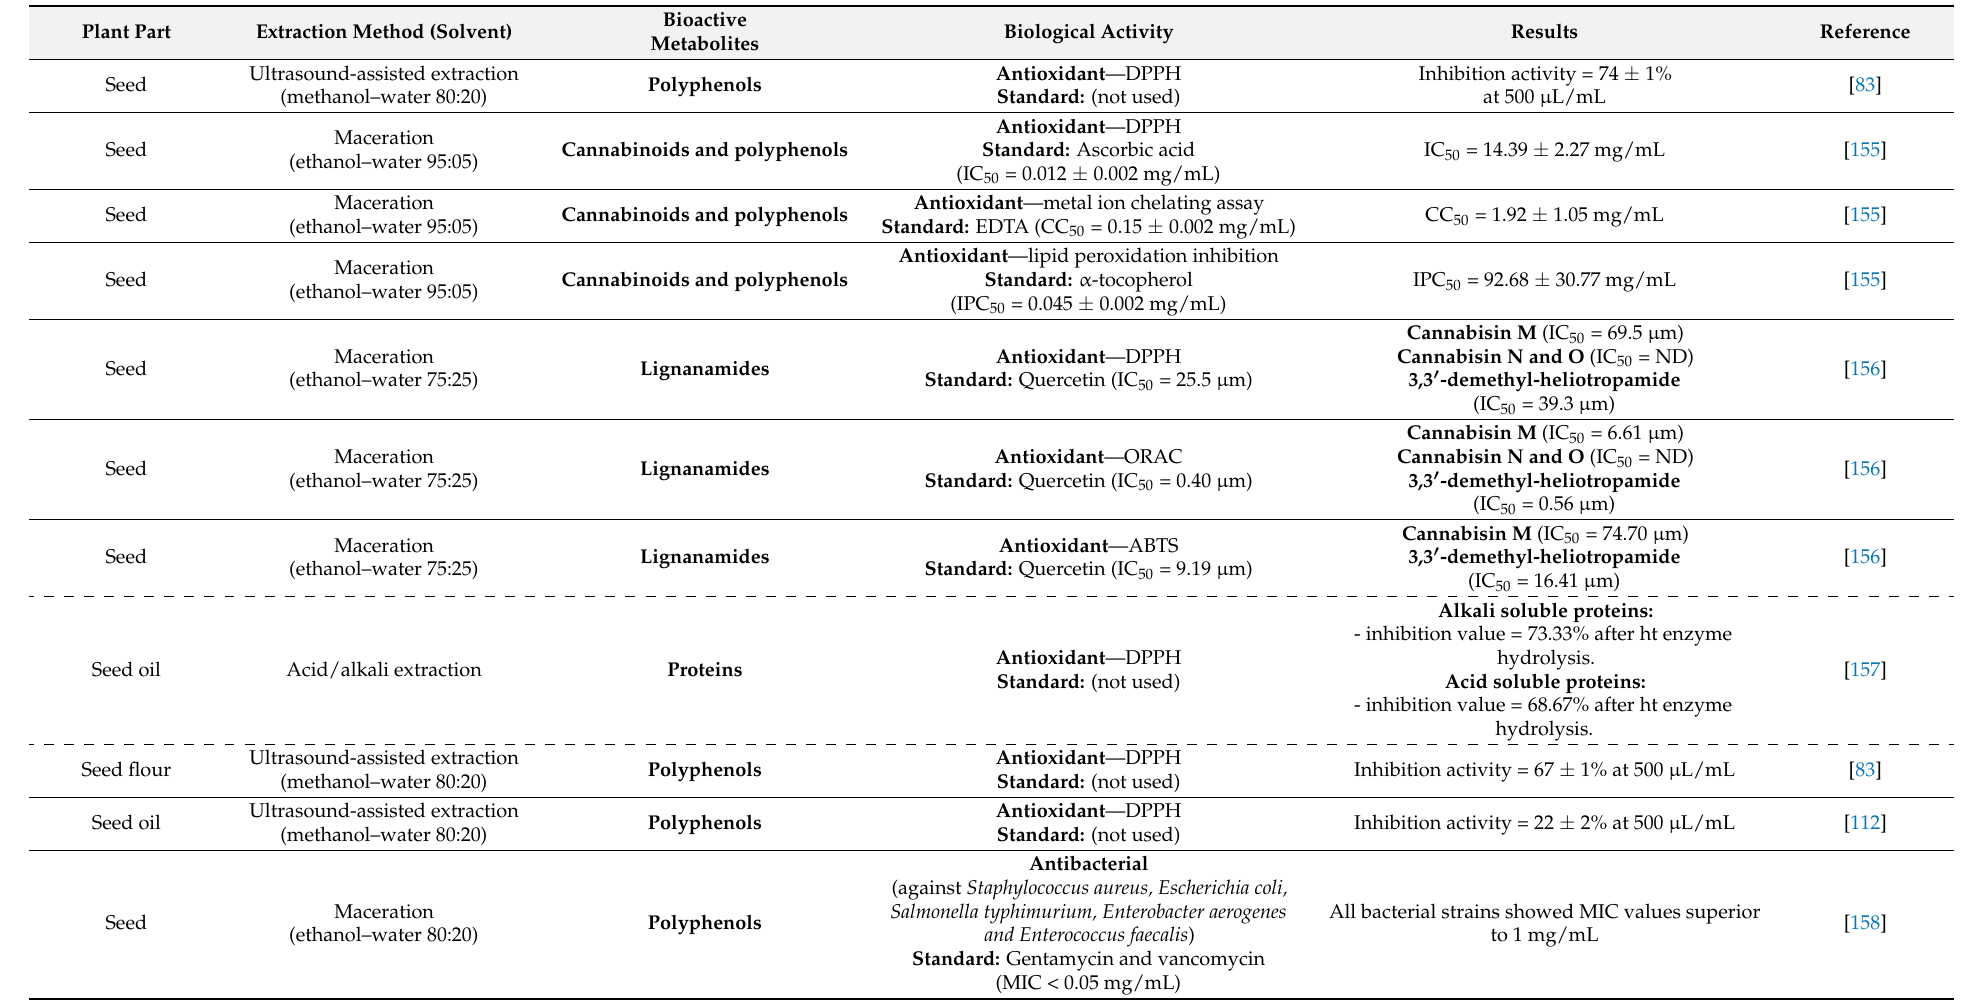
Table 4. Biological activities of different parts of Cannabis sativa